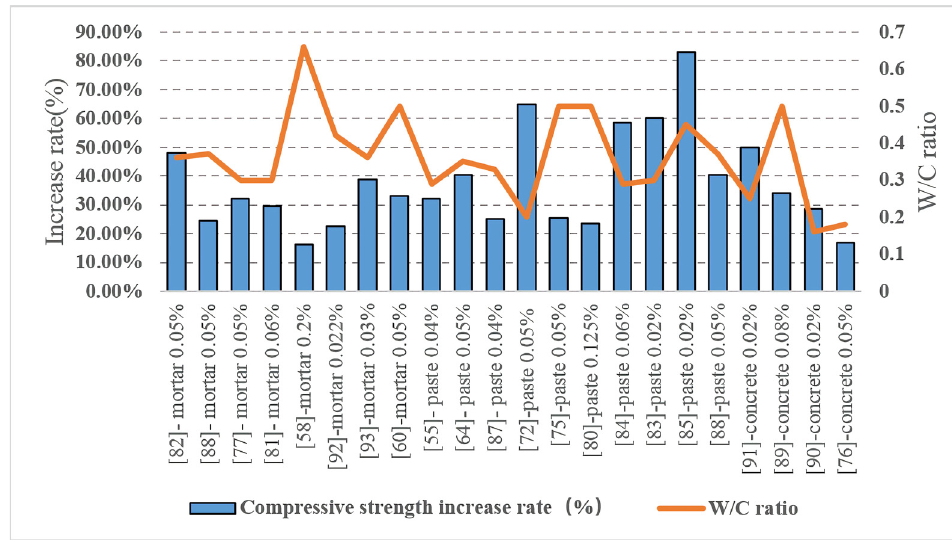
Figure 10: Compressive strength enhancement of GO reinforced cement composite specimens.